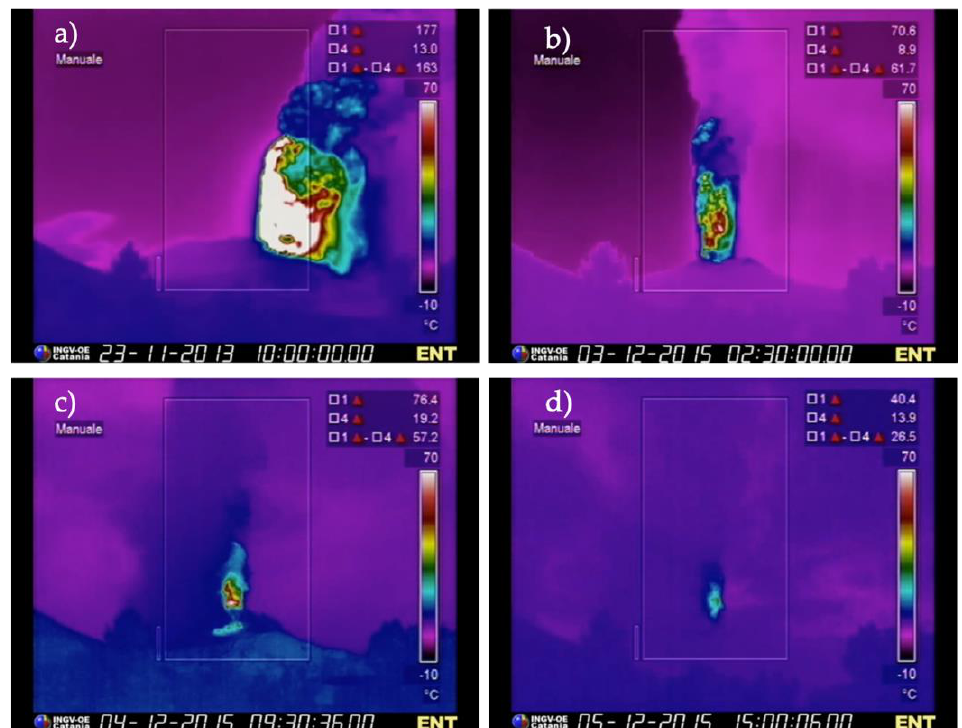
Figure 3. Frame of the TIR camera in Nicolosi (named ENT) showing the lava fountains from the NSEC for 23 November 2013, panel ( a ), and from the VOR for 3–5 December 2015 panel ( b – d ). On the black line below each image, the date (dd‐mm‐yyyy) and UTC time (hh:mm:ss:00) of the Etna eruptive event are given,